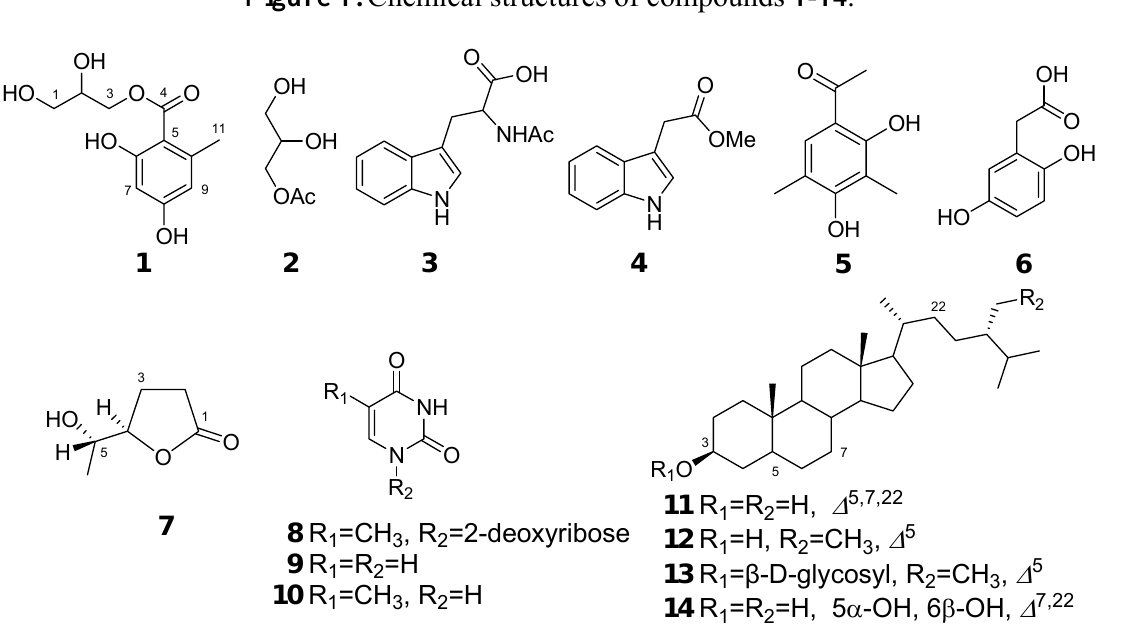
Figure 1. Chemical structures of compounds 1 - 14